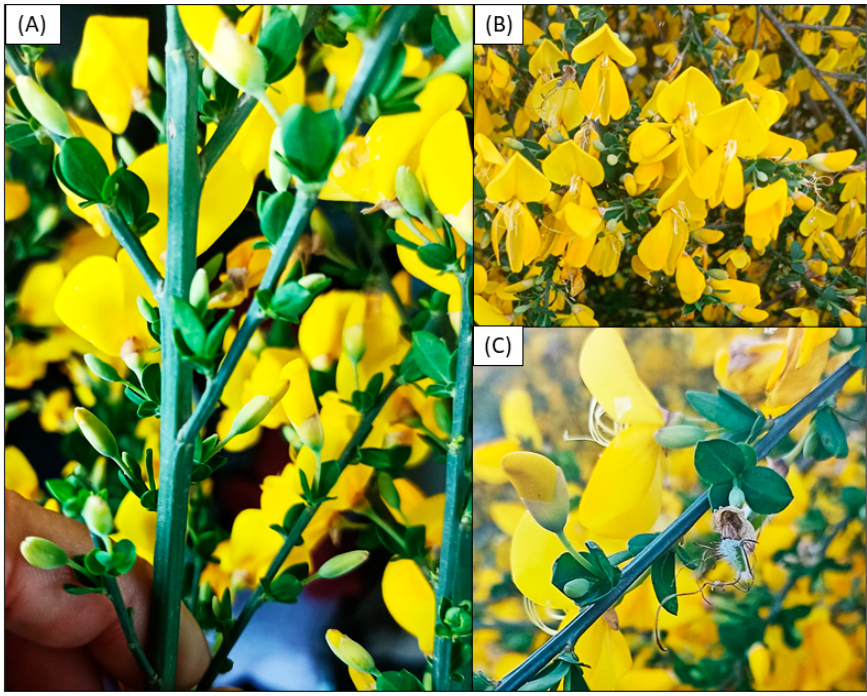
Figure 3. Some examples of C. scoparius in the Beira Alta region (Portugal); ( A ) stems of the shrub; ( B ) its flower; ( C ) the leaves.